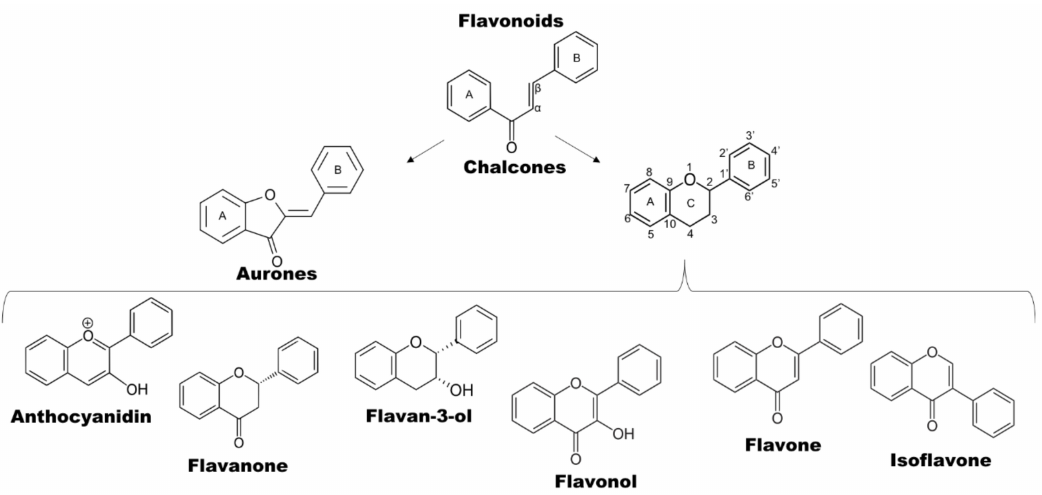
Figure 2. Subclasses of flavonoids. The central structure of flavonoids is shown for flavan, and for each subgroup the corresponding structure is shown as described in the text. Adapted from